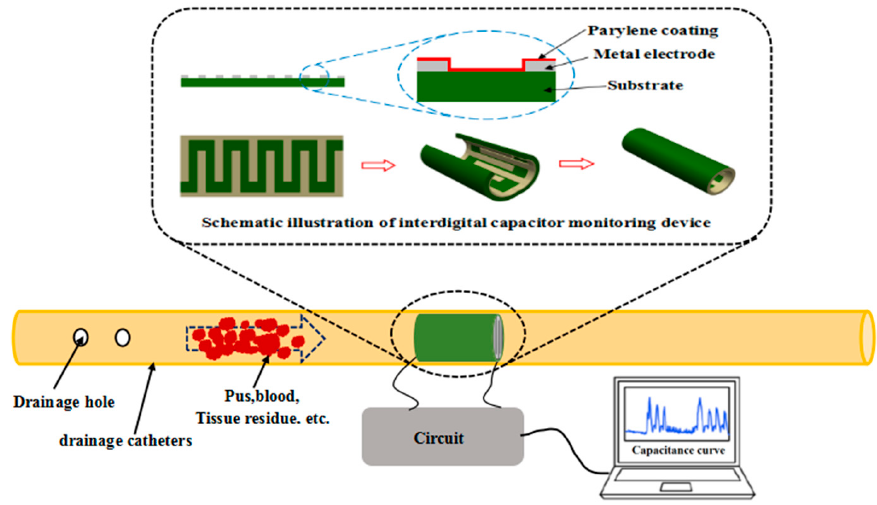
Figure 1. Schematic and detection principle of the interdigital capacitance device for drainage state monitoring.